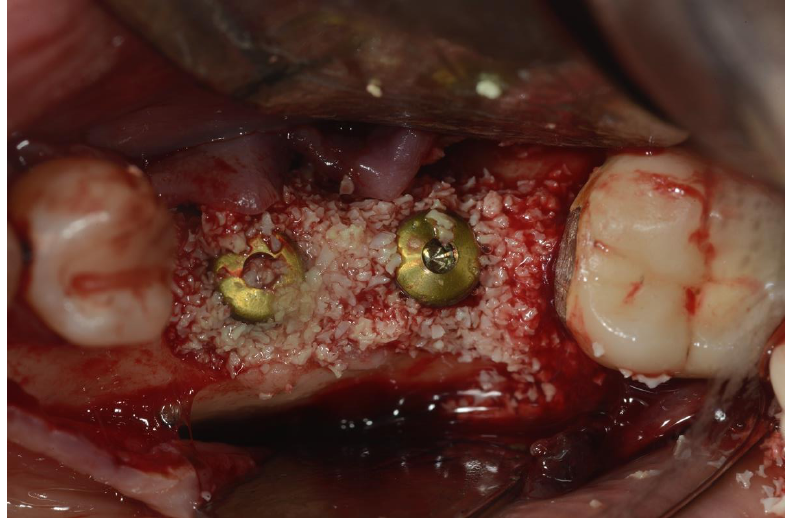
Figure 4. Placement of bovine particulate graft material.